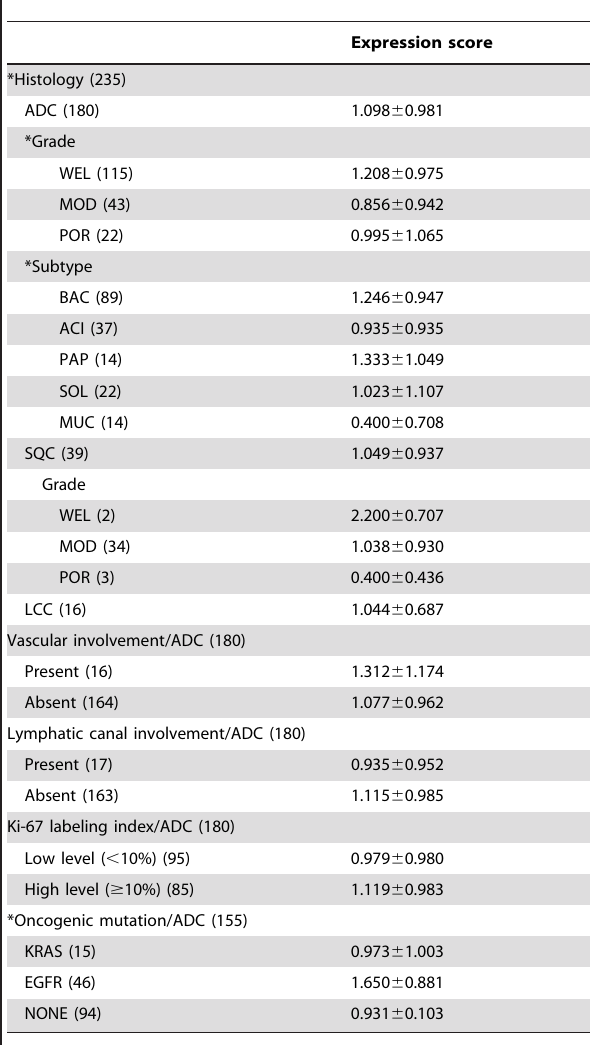
Table 2. Correlation between CLIC4 expression and pathologic